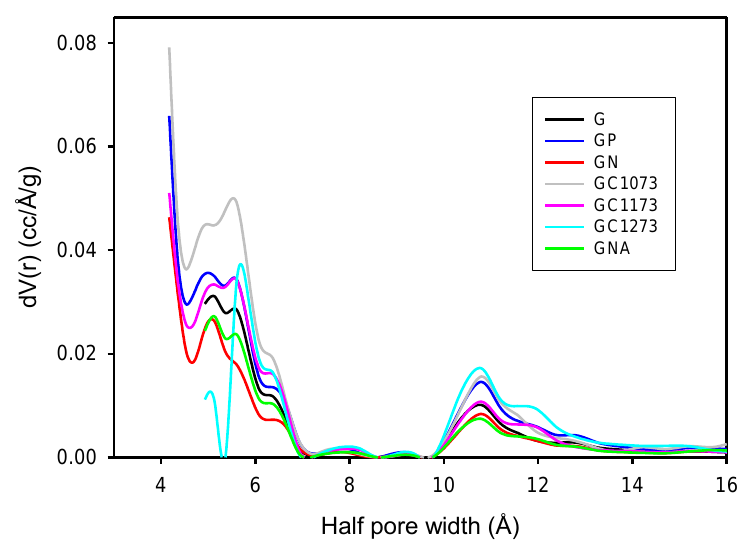
Figure 3. Distribution of micropore size from QSDFT model.